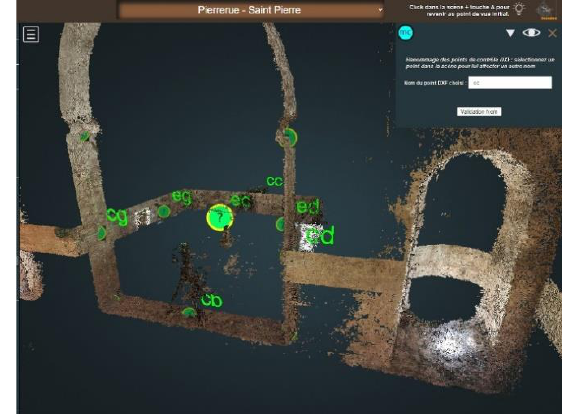
Figure 4 : View of the spheres, in yellow, allowing access to the panoramas, arranged according to the pyramidal survey protocol shown in purple.